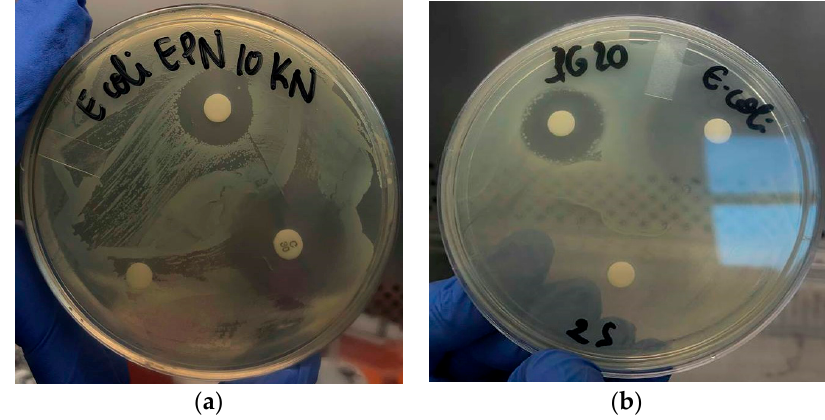
Figure 7. The e ff ect of EOs extracted from ( a ) BS and ( b ) JP on the E. coli